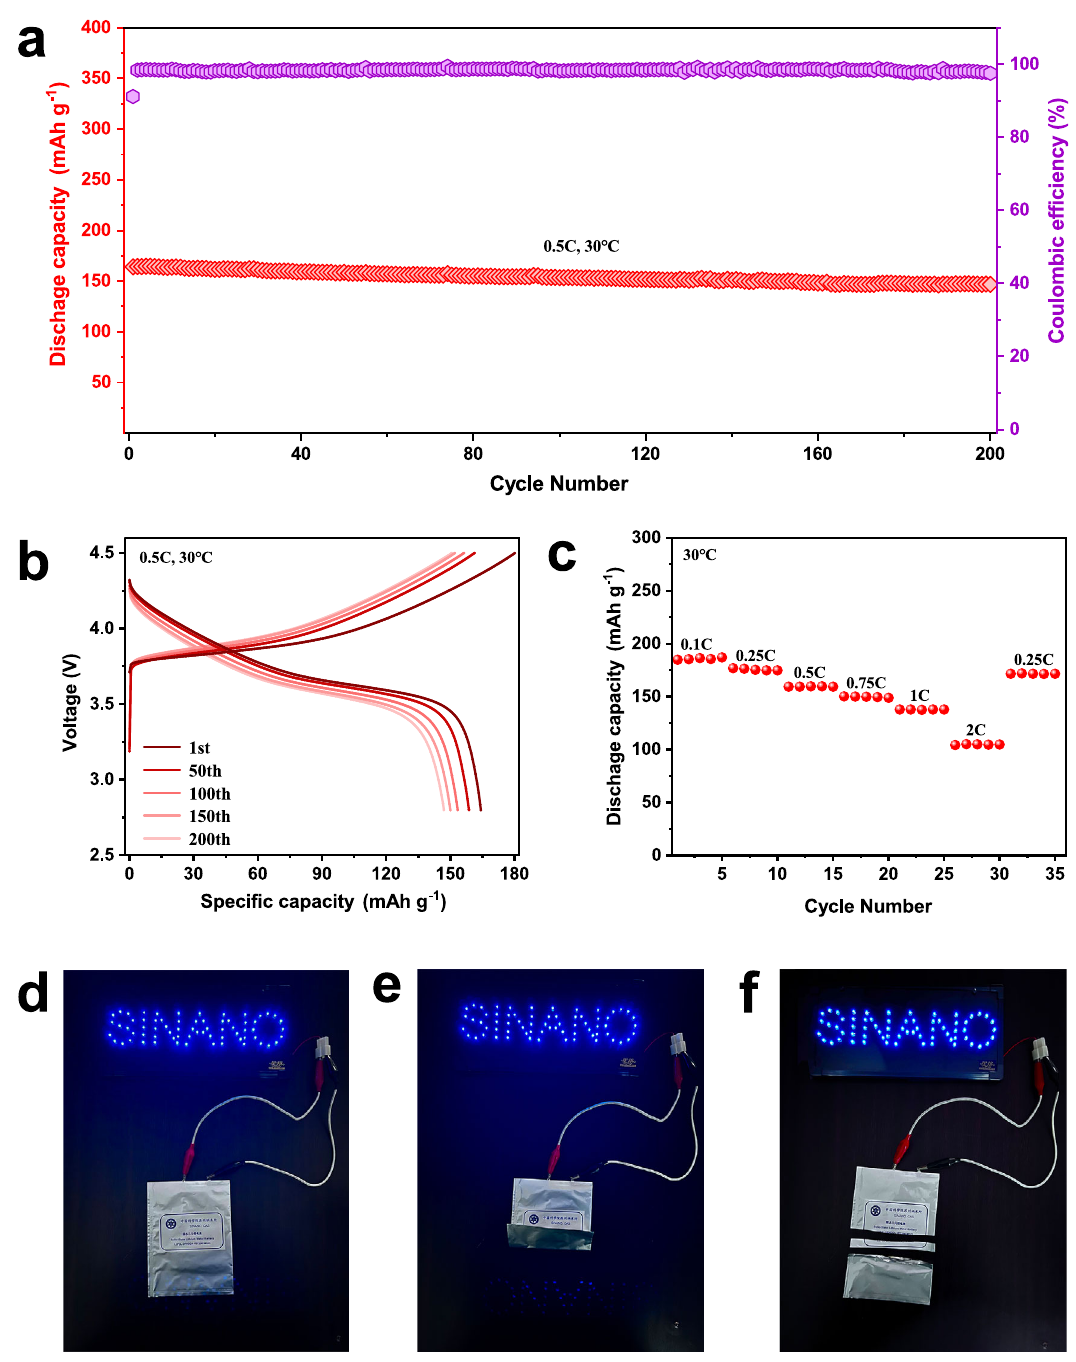
Fig.6|ElectrochemicalperformanceofthefullcellwiththestructureofLi|P(IL- OFHDODA-VEC)|NCM523. a Cycling performance of Li|P(IL-OFHDODA-VEC)| NCM523 full cell at 0.5C. b 1 – 200th charge and discharge curves of Li|P(IL-